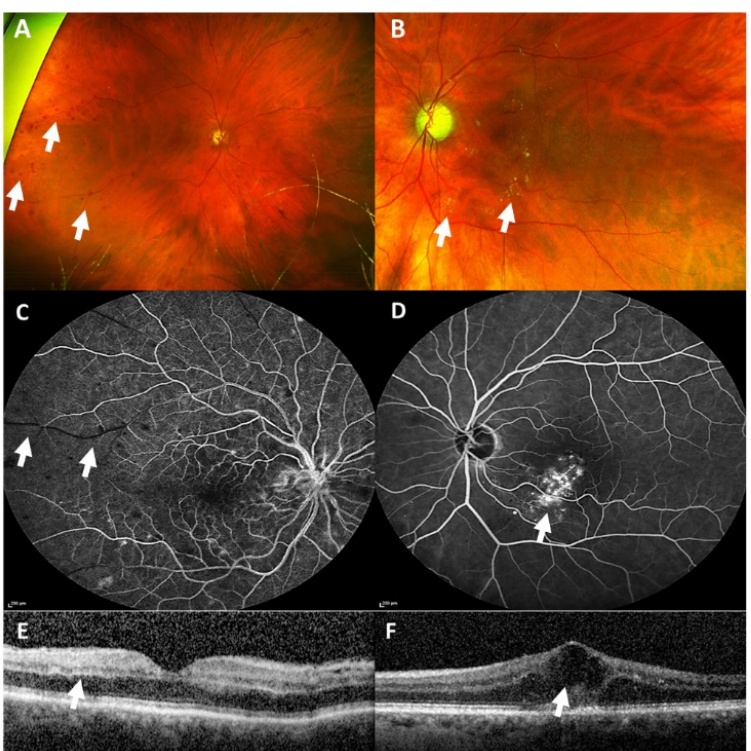
Figure 2. Wide-angle fundus photography ( A , B ) revealed multiple intraretinal hemorrhages in the right eye (white arrows, A ) and hard exudates, seen as yellowish circumscribed spots, in the left eye (white arrows, B ). Fluorescein angiography ( C , D ) showed an arterial capillary non-perfusion (white arrows, C ) in the right eye and vessel leakage inferior of the macula in the left eye, seen as hyperfluorescent non-well circumscribed area (white arrow, D ). Optical coherence tomography ( E , F ) revealed a hyperreflectivity of inner retinal layers as a sign of an arterial occlusion (white arrow, E ) in the right eye, and a cystoid macular edema (white arrow, F ) in the left eye.